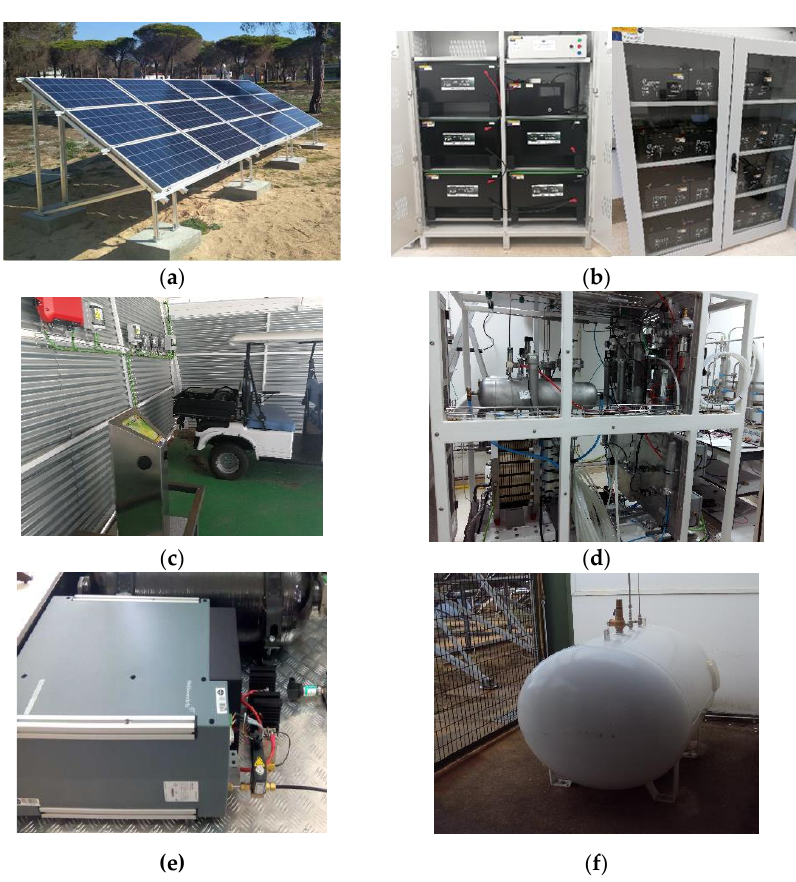
Figure 2. Detail of the microgrid components of Figure 1: ( a ) photovoltaic field; ( b ) Li-ion (left) and lead-acid battery (right); ( c ) Electric vehicle (white car on the background); ( d ) Alkaline electrolyzer; ( e ) polymer electrolyte membrane fuel cell; and ( f ) pressurized hydrogen tank.